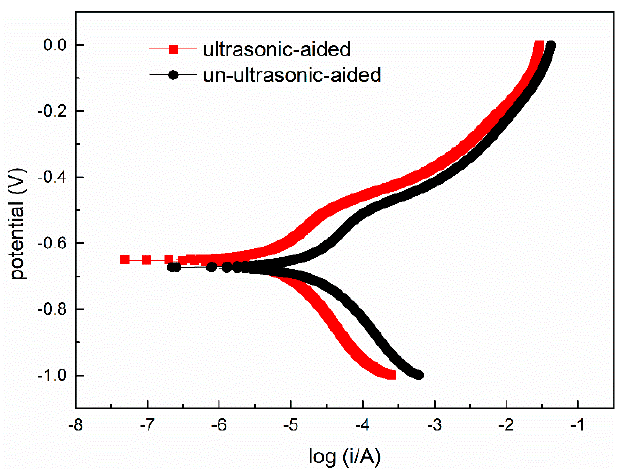
Figure 6. Potentiodynamic polarization curves of 35CrMoV in the artificial seawater solution.